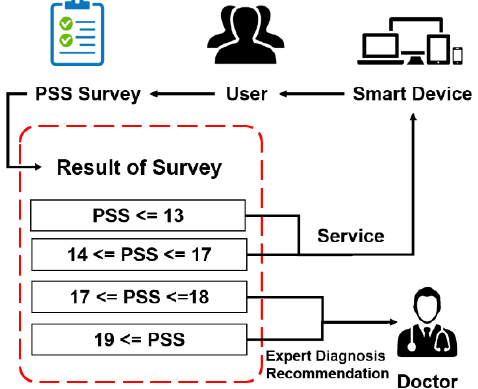
Figure 1. Process of stress management service using the Perceived Stress Scale (PSS).